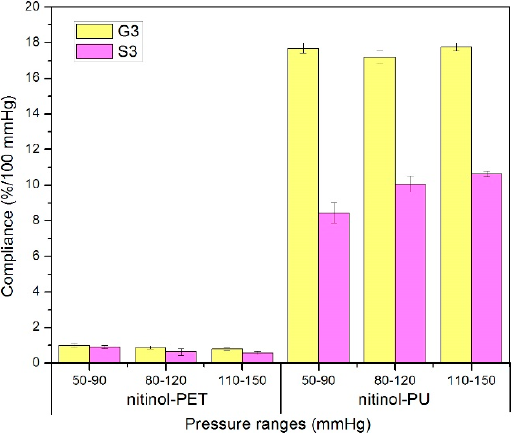
Figure 15. Compliance of nitinol-PET and nitinol-PU stent grafts in unstented zone G3 and stented zone S3.